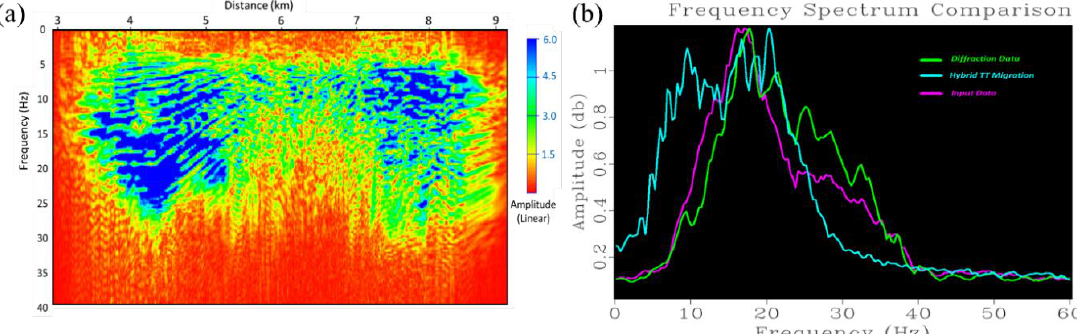
Figure 13. ( a ) The amplitude spectrum of the migrated data shows a linear distribution of the amplitude energy. ( b ) Frequency spectrum of input data (purple), diffraction data (green), and migrated data using hybrid travel time (blue).